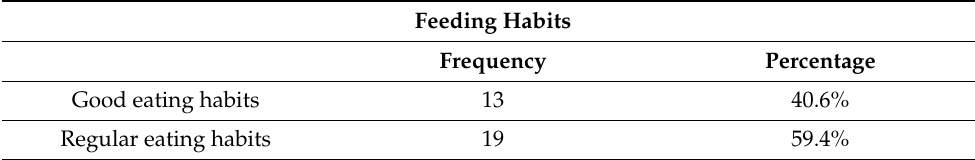
Table 3. Children’s Eating Habits and Percentage.